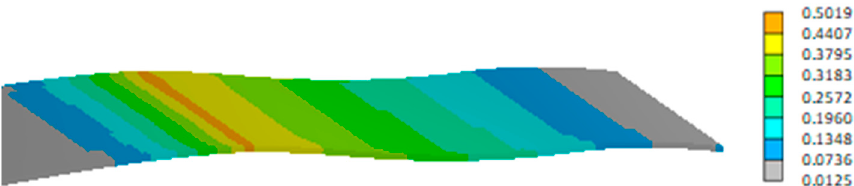
Figure 27. Inverse reserve factors in the skin- extension according to Puck’s failure criterion in high-lift configuration (S5); IRFs are higher than in cruise-configuration but still acceptable.